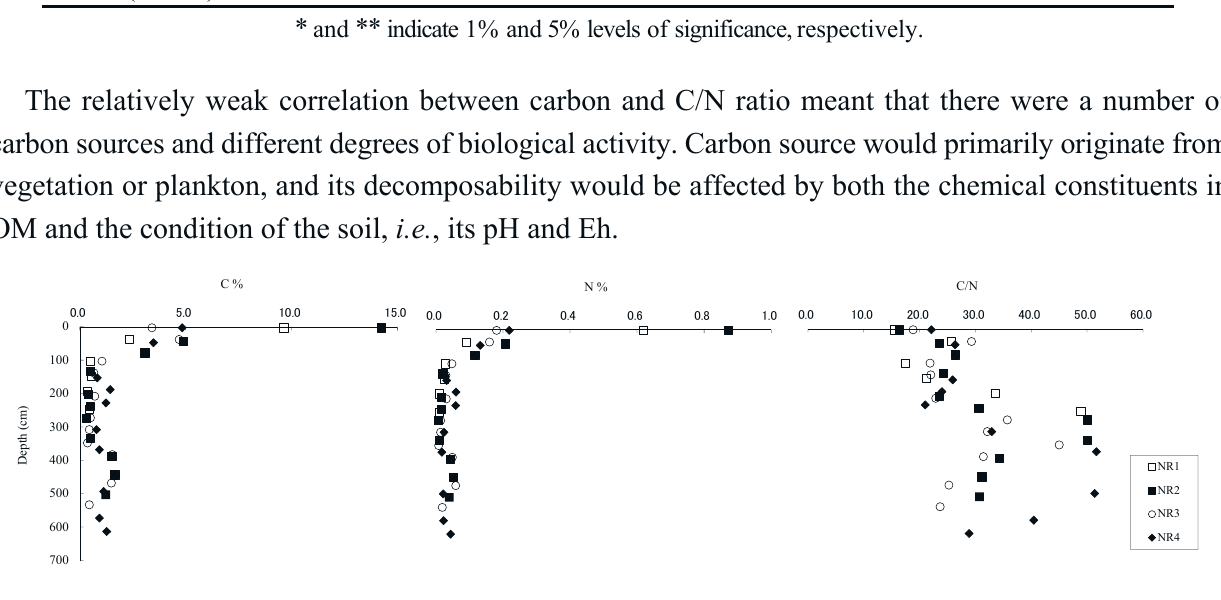
Figure 7. Belowground OC and N contents, and C/N ratios at different depths along